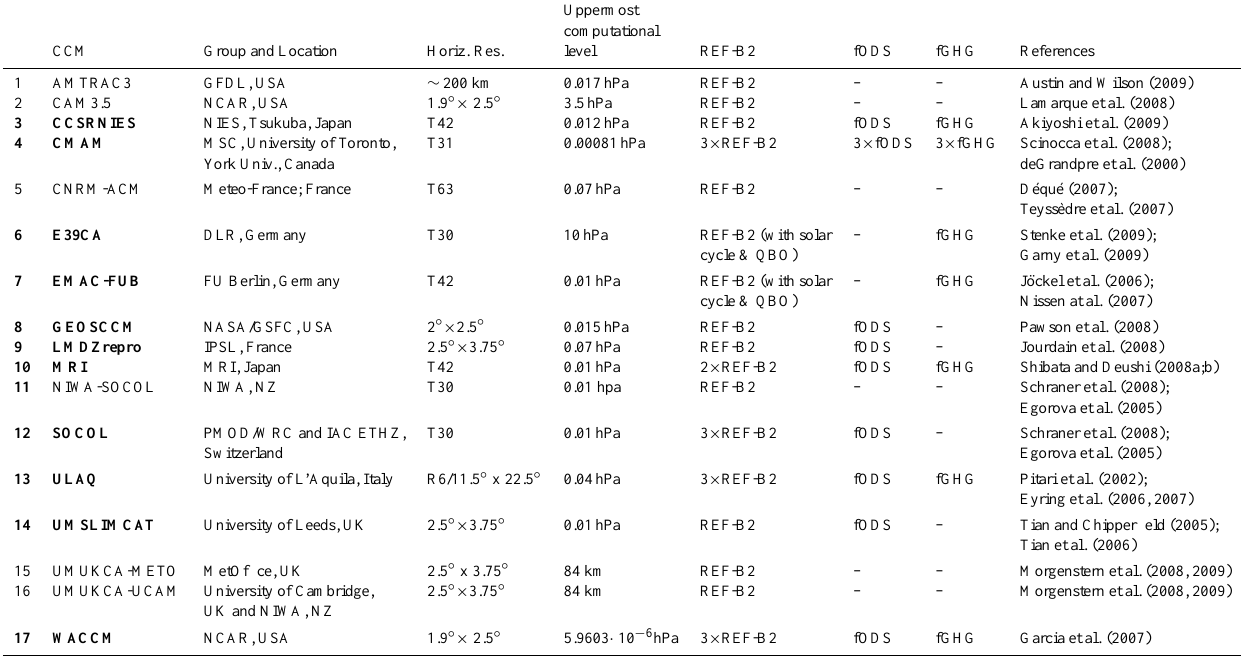
Table 1. A summary of the CCMs and simulations used in this study. REF-B2 is the future reference simulation, fODS is a simulation with fixed ODSs and fGHG a simulation with fixed GHGs. Further details on the models can be found in Morgenstern et al. (2010) and SPARC CCMVal (2010) as well as in the references given below. CCMs that contributed sensitivity simulations are highlighted in bold. N × REF-B2 means that the group provided N realizations of this simulation. T42 approximately corresponds to 2.8 ◦ × 2.8 ◦ , T30 to 3.75 ◦ × 3.75 ◦